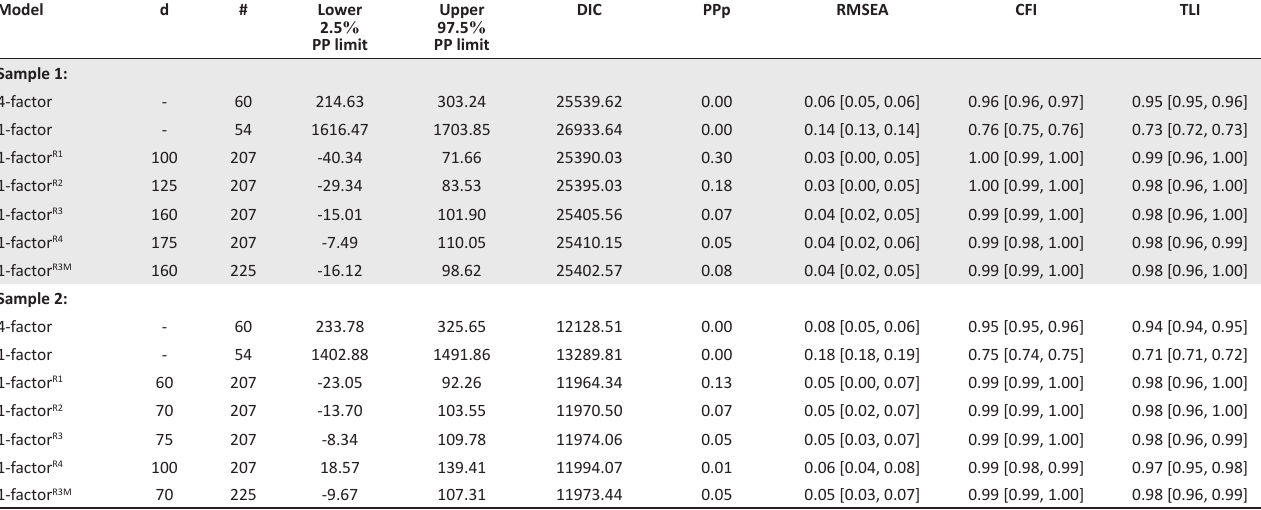
TABLE 1: Bayesian structural equation modeling model fit indices for the tested confirmatory factor analysis models.